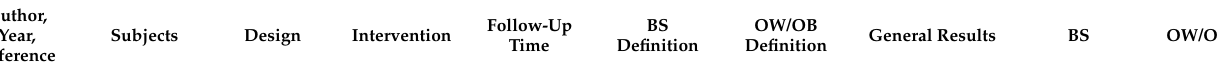
Table 1. Characteristics and results of longitudinal studies included in the systematic